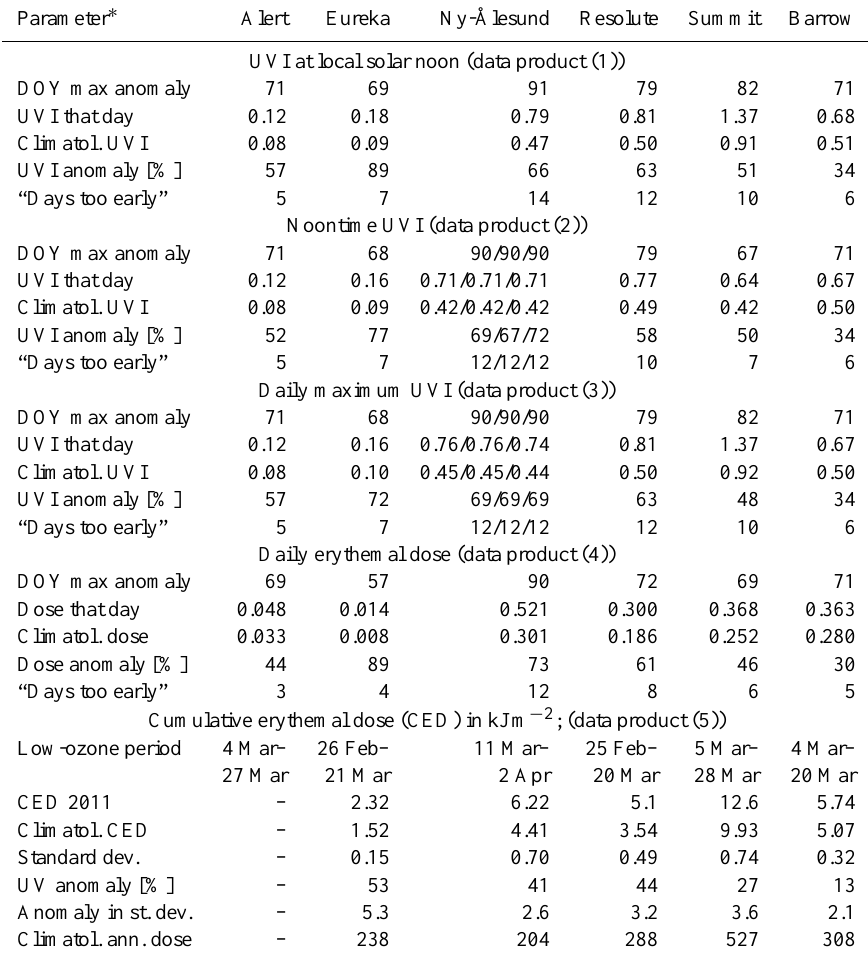
Table 4. Statistics for non-Scandinavian sites. For Ny-Ålesund, statistics are provided for the native data set and subsampled data sets at 15 and 60min intervals, separated by a